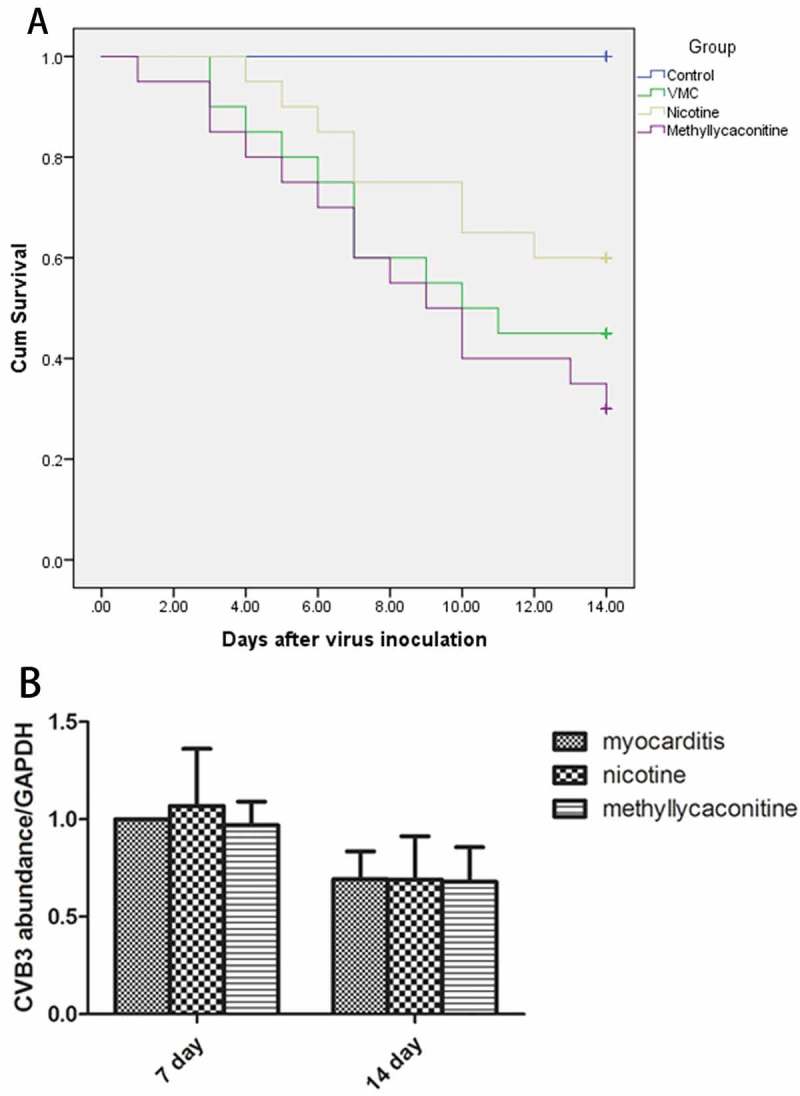
Survival rate (n = 40 in each group) and Viral replication in the myocardium (n = 5 in each group). A. The survival curve of each group. B. Viral replication in the myocardium of each group.